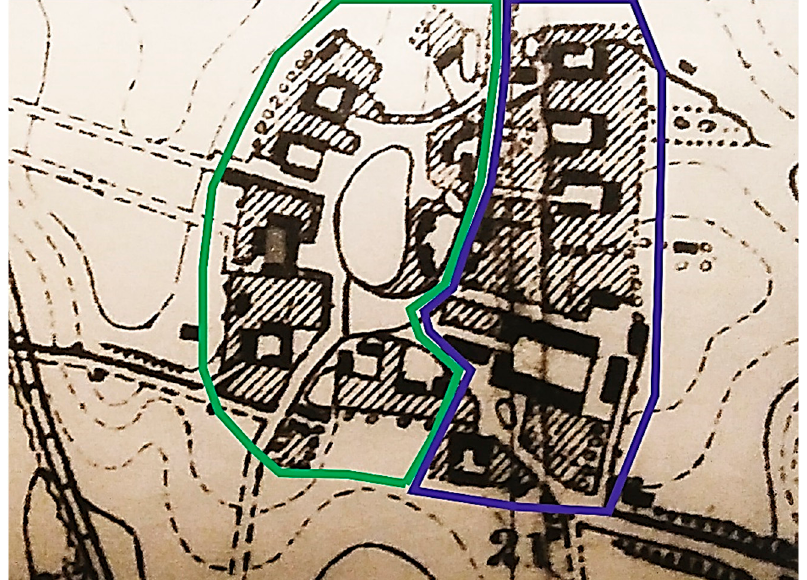
Figure 3. Plan of the village of Modlimowo from 1871. Two zones of village development are marked on the plan. Created by author.